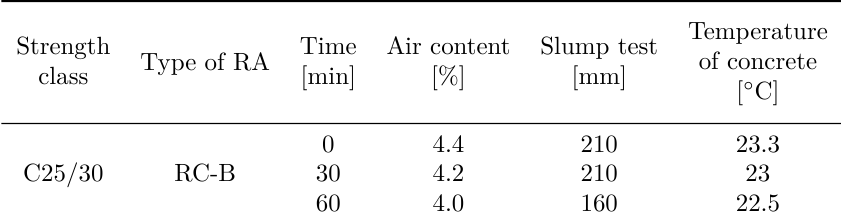
Table 6. Results of workability testing in